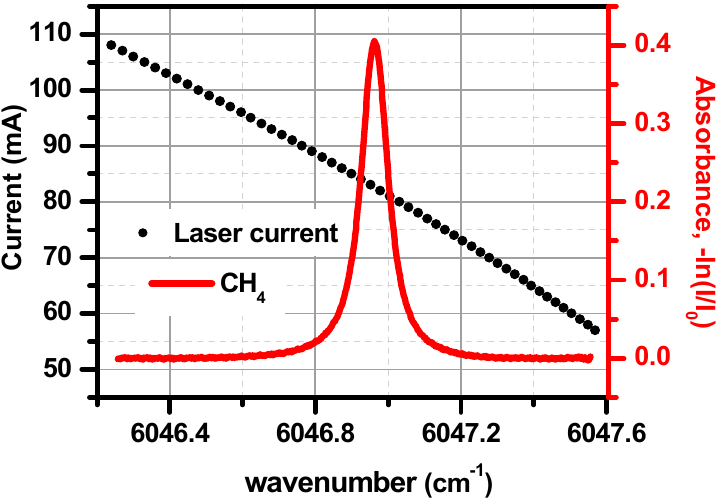
Figure 4. Absorption spectrum of methane near 6046.95 cm − 1 . Left axis: laser current (vs. laser frequency); Right axis: absorbance of the methane absorption line.